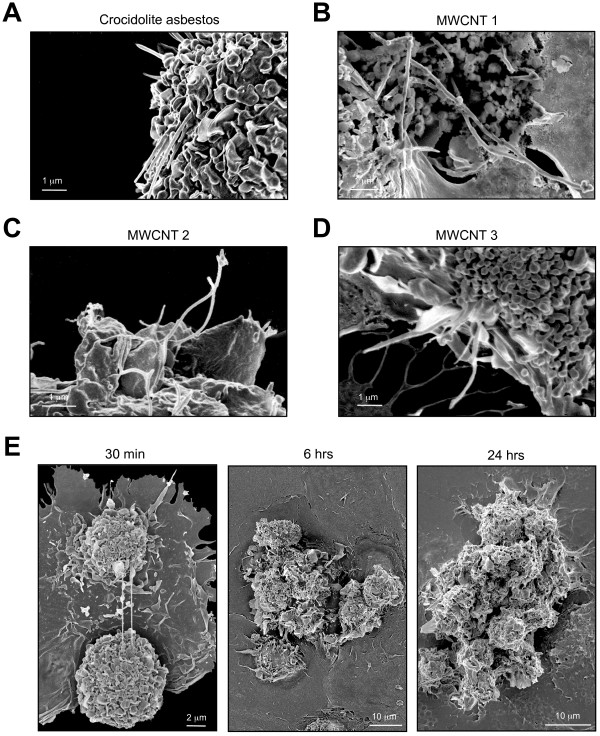
Phagocytosis of asbestos fibers and MWCNTs and cell aggregation in 3D cultures. A-D) Evidence of frustrated phagocytosis after 6 hrs of exposure to 1.25 μg/ml of asbestos fibers or MWCNTs. At the times specified, 3D cultures were transferred to a glass-coverslip, incubated for 15 min to allow re-attachment and fixed for examination by scanning electron microscopy. A) Crocidolite asbestos fibers. B) MWCNT 1. C) MWCNT 2. D) MWCNT 3. E) Time course of cell aggregation after exposure to 1.5 μg/ml of MWCNT 1 in 3D cultures.